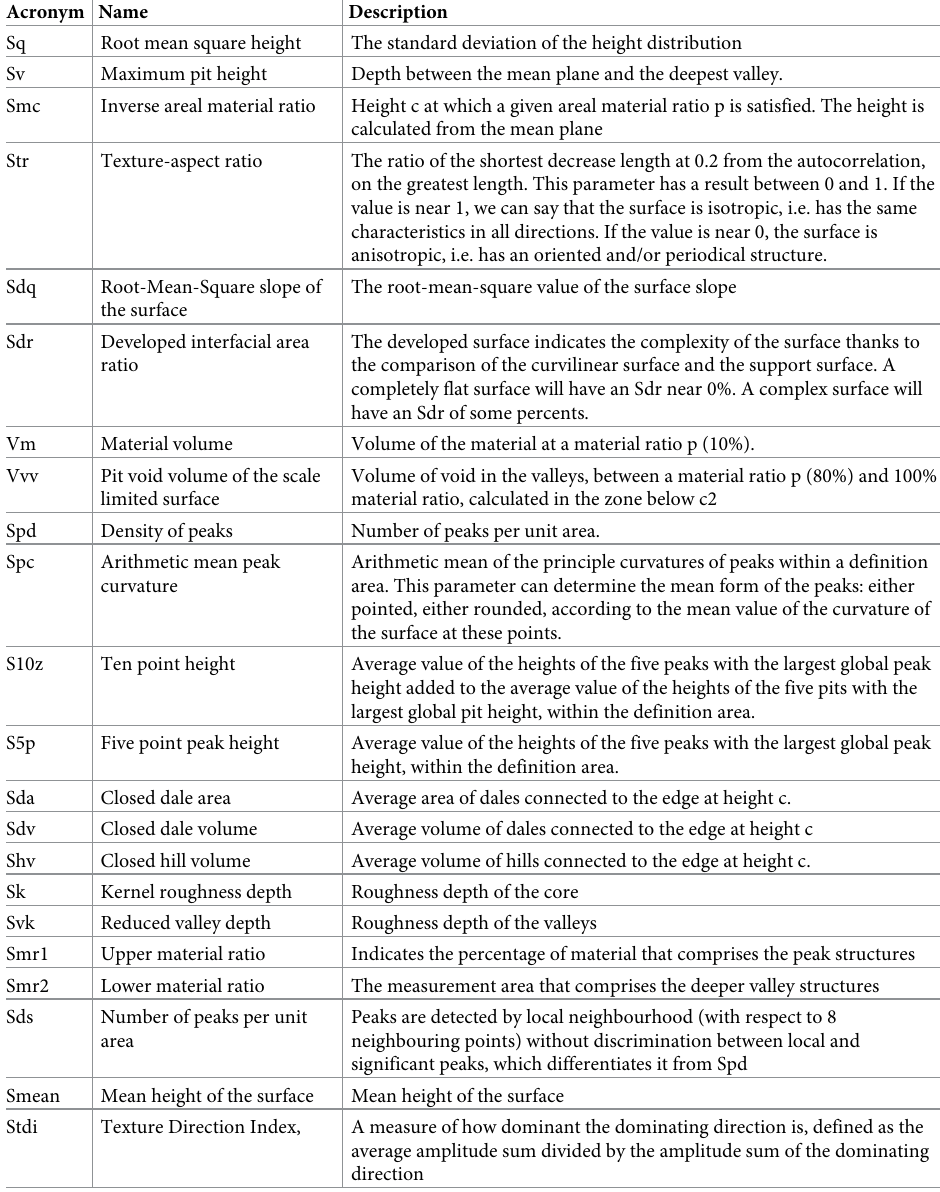
Table 1. Parameters of texture used in the